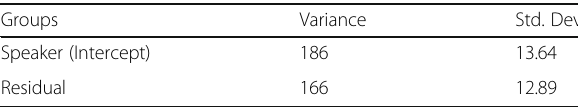
Table 11 Random effects